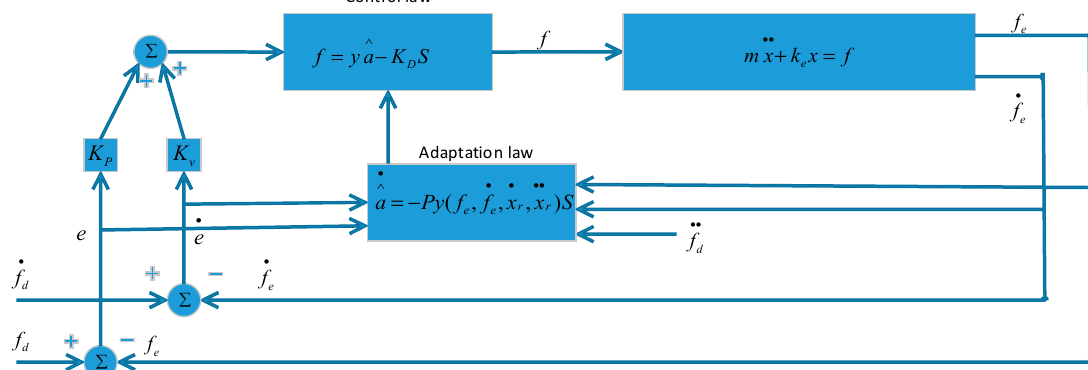
Figure 8. Control system for 1-DOF manipulator.